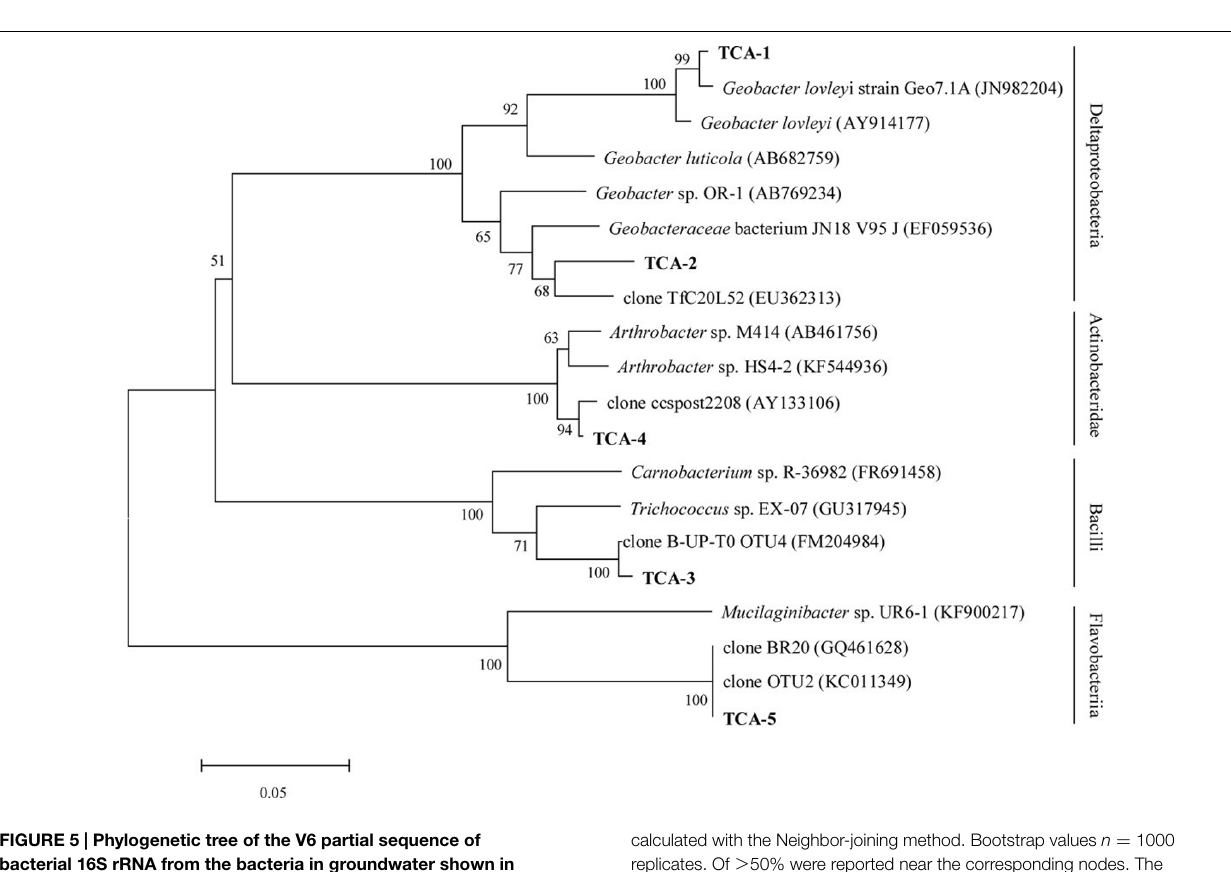
FIGURE 5 | Phylogenetic tree of the V6 partial sequence of bacterial 16S rRNA from the bacteria in groundwater shown in boldface and the referred sequences in the EMBL database with the putative divisions listed to the right. The topology show was